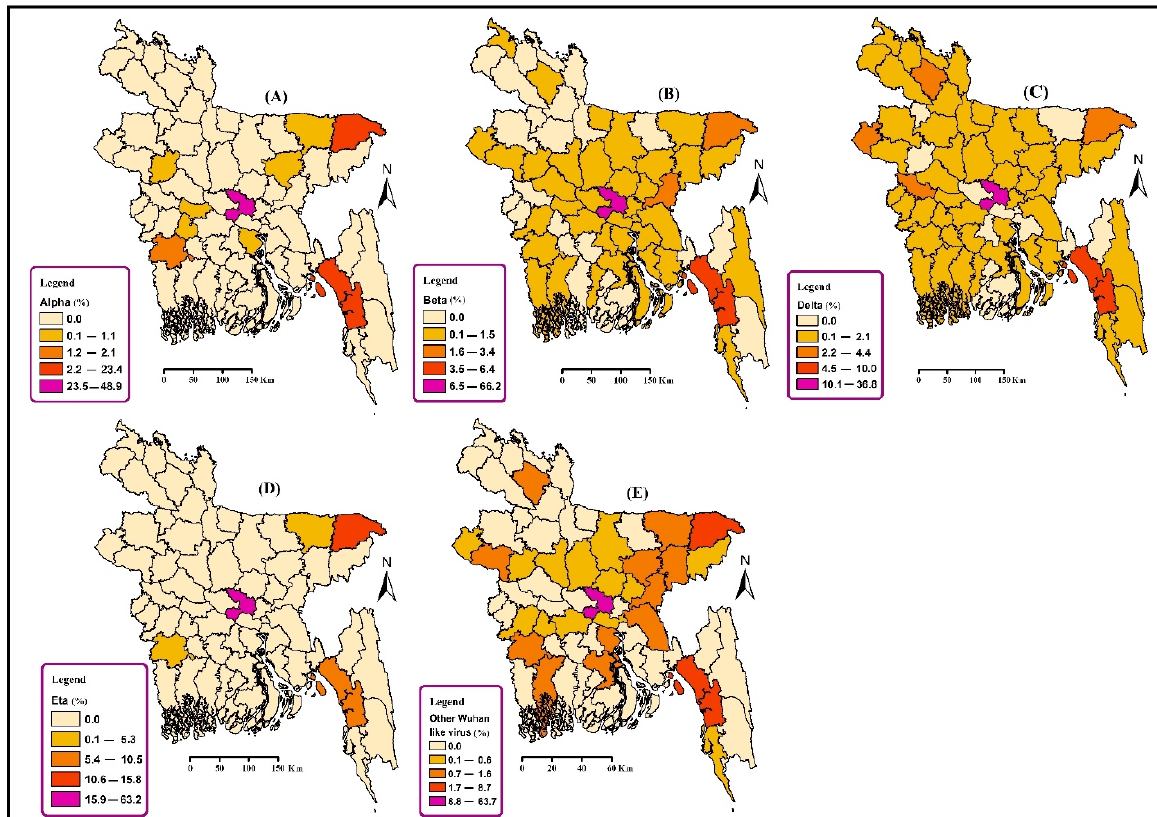
Figure 3. Spatial distribution of ( A ) Alpha variants (%); ( B ) Beta (%); ( C ) Delta (%); ( D ) Eta (%) variants of SARS-CoV-2; and ( E ) other Wuhan-like strains (%) in Bangladesh from December 2020 to 15 September 2021. We have omitted the Gamma variant as only one sequence has been reported in GISAID and visualization of a single virus might mislead the geographic distribution of the variant.